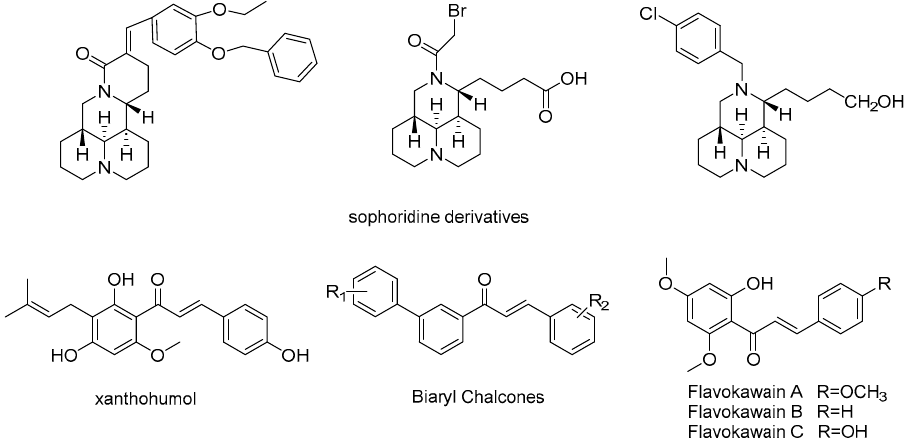
Figure 1. Sophoridine and chalcones derivatives bearing anticancer activities.